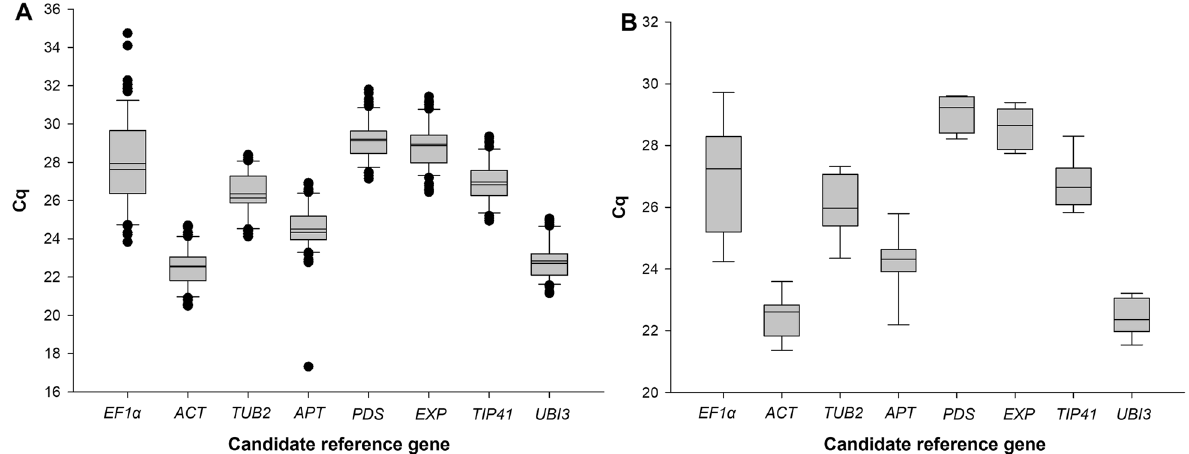
Figure 1. Variations in RT-qPCR Cq values of eight tomato genes/alleles [viz. actin ( ACT ), adenine- phosphoribosyl-transferase 1 ( APT ), β-2-tubulin ( TUB2 ), elongation factor 1-alpha ( EF1α ), the